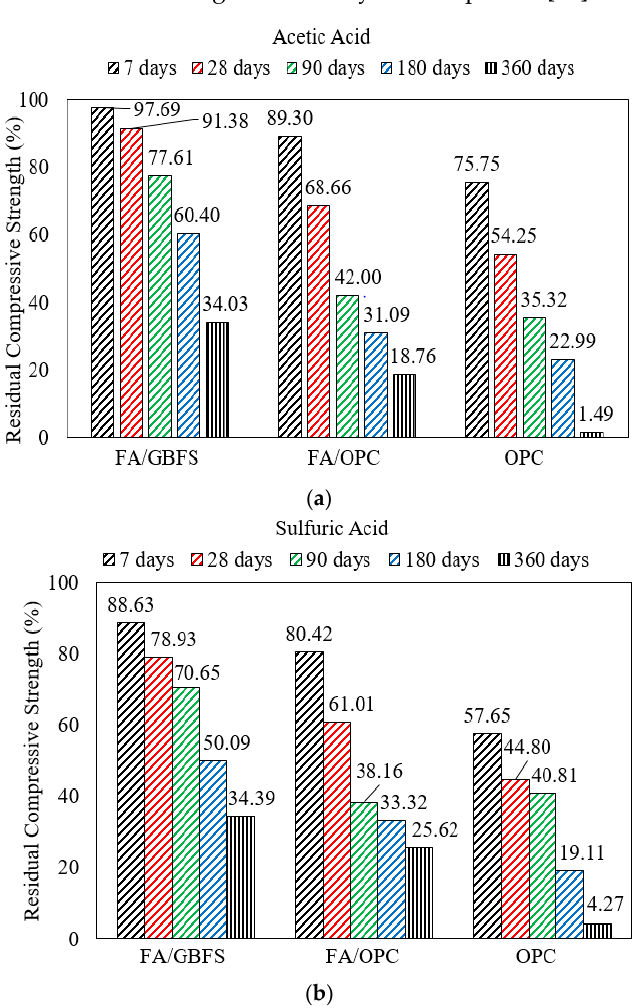
Figure 3. Strength degradation of mortar with various binders including AASF with fly ash: slag = 4:1, fly ash: OPC = 4:1, or 100% OPC in ( a ) acetic acid ( b ) sulfuric acid [50].